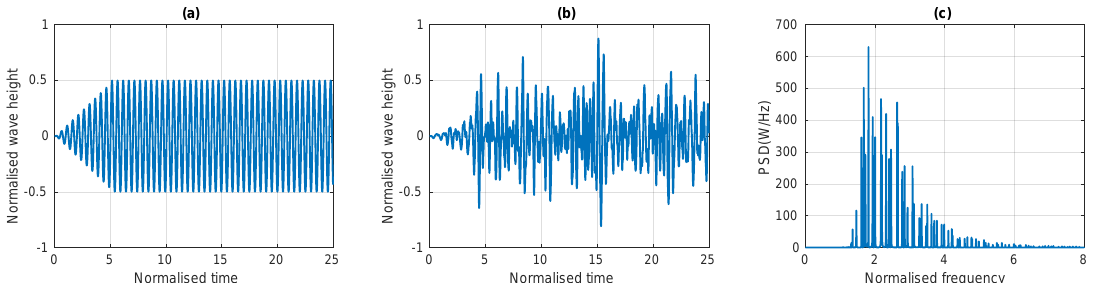
Figure 1. Example of the input waves: ( a ) monochromatic, ( b ) polychromatic, ( c ) power spectral density (PSD) of the polychomatic